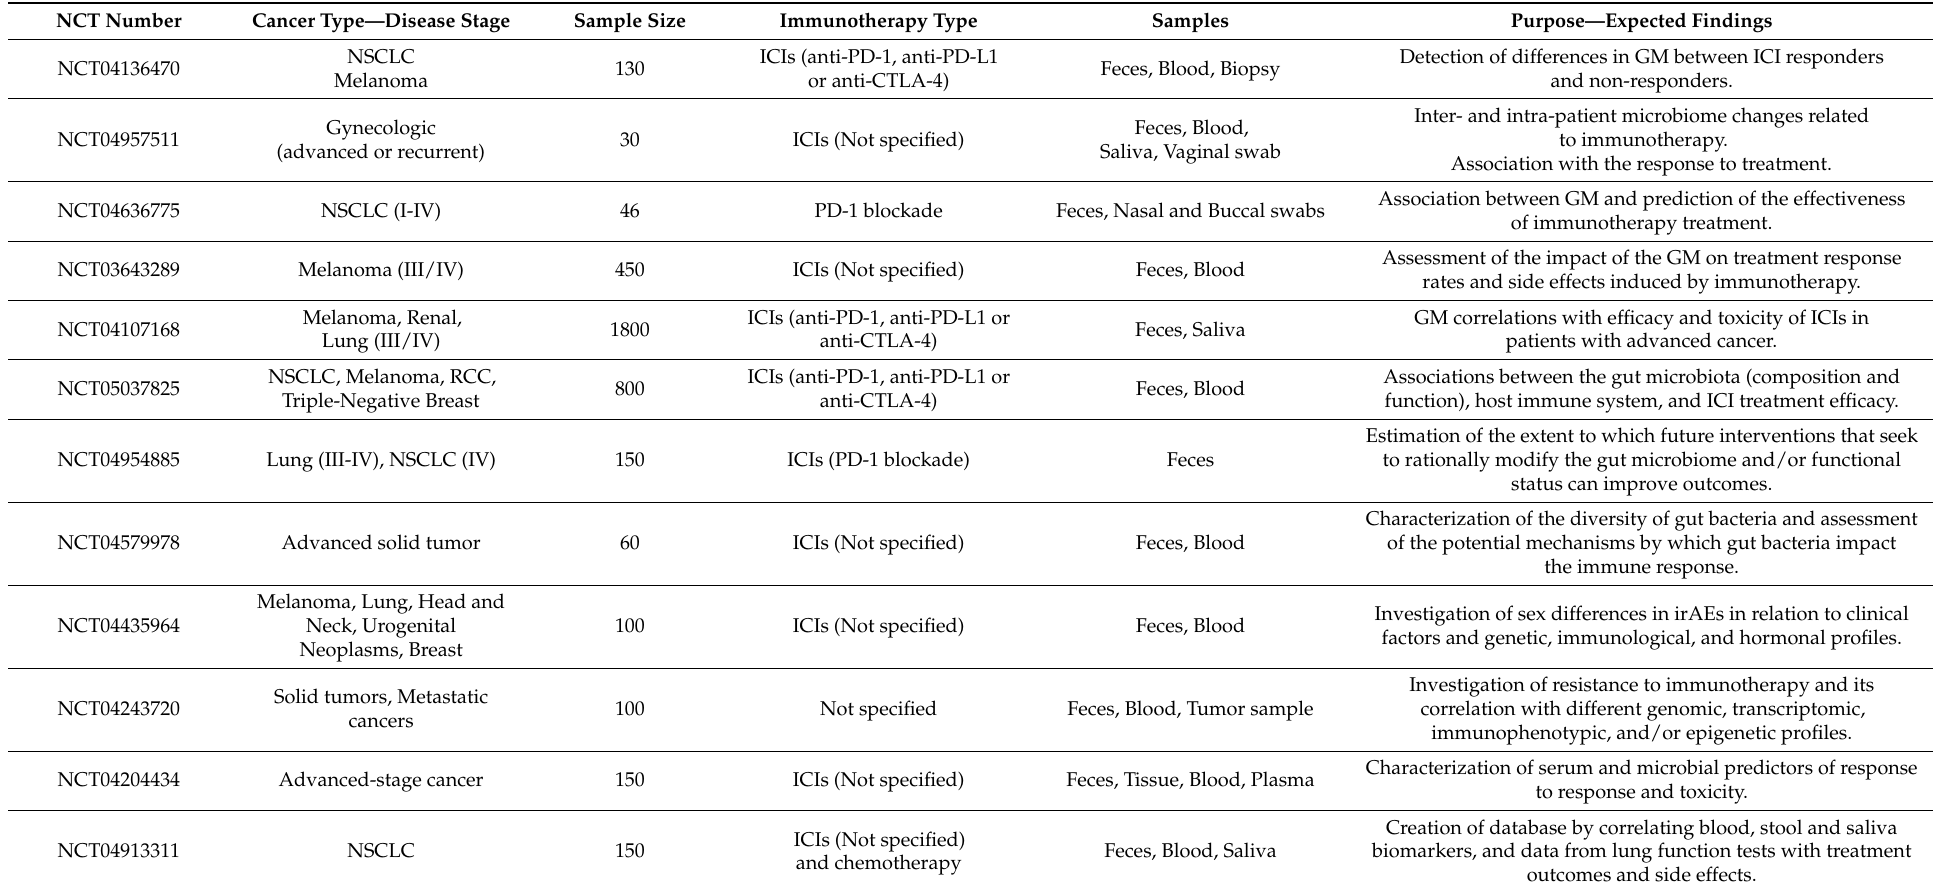
Table 2. Ongoing observational clinical trials investigating the effect of gut microbiota composition on ICI immunotherapy efficacy and therapeutic